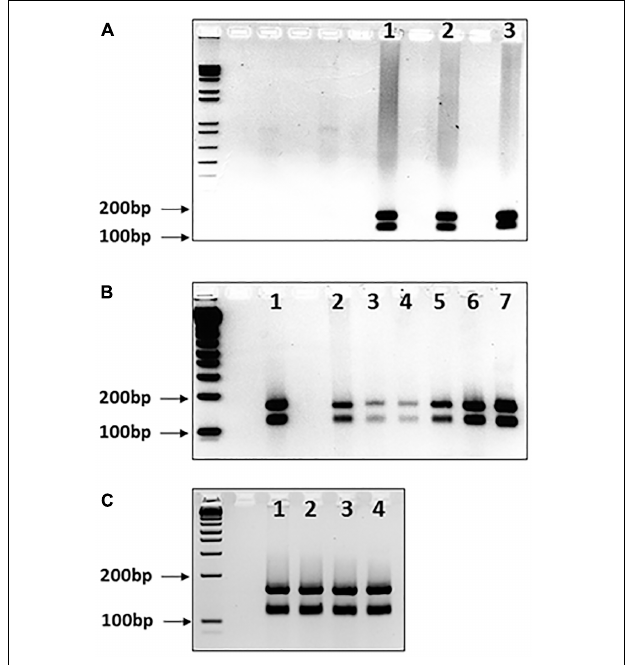
FIGURE 3 | Mbo II digests of GAA repeat expansions from human FRDA somatic tissues and mouse FRDA intergenerational and somatic tissues. Agarose gels showing Mbo II digests of GAA PCR products of (A) FRDA patient cerebellum tissue samples, (B) YG8sR mouse ear biopsy samples and human FRDA blood samples, and (C) four tissues from one YG8sR mouse. In each case, the expected 170 and 120bp undigested GAA-flanking fragments can be identified in between the 200 and 100bp fragments of the 1 Kb+ DNA ladder marker, which is loaded into the first lane of each gel. (A) Lanes 1–3 show the results from cerebellum tissue samples from three FRDA patients. (B) Lanes 1 and 2 are from FRDA patient blood samples; lanes 3–6 are from ear biopsy samples from 4 GAA repeat expansion-based YG8sR mice of four different generations, and lane 7 is from an ear biopsy sample from the Y47R mouse which has nine GAA repeats. (C) Lanes 1–4 are from brain, cerebellum, heart, and liver tissues of the YG8sR mouse,